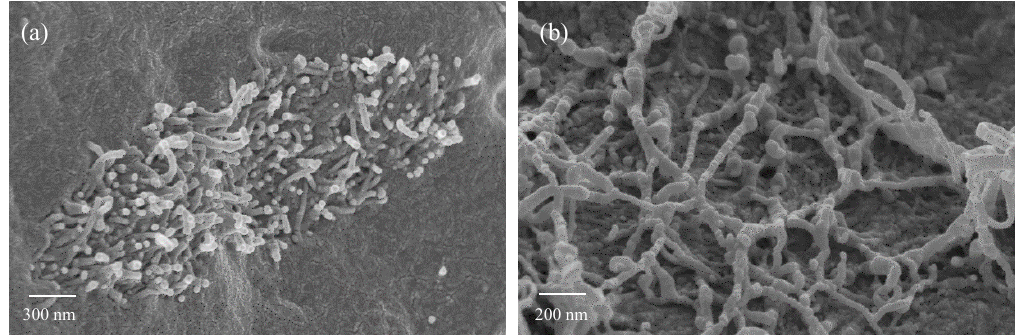
Figure 7. (a) PP/CNT ‐ 3, (b) PP/CNT ‐ 5 and c) PP/CNT ‐ 7. White arrows indicate single dispersed CNTs; white ellipsis indicate CNTs agglomerates Figure 8. (a) CNTs agglomerate and (b) detail of CNTs Figure 8. ( a ) CNTs agglomerate and ( b ) detail of CNTs.